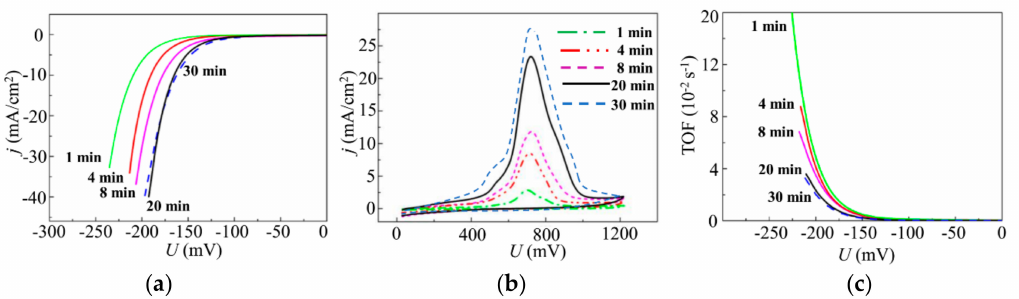
Figure 13. ( a ) Polarization curves. ( b ) Anodic cyclic voltammograms. ( c ) TOF dependence on voltage for the MoS x ~3 + δ catalysts obtained on the GC substrate by o ff -axis PLD in Ar at 8 Pa for di ff erent deposition